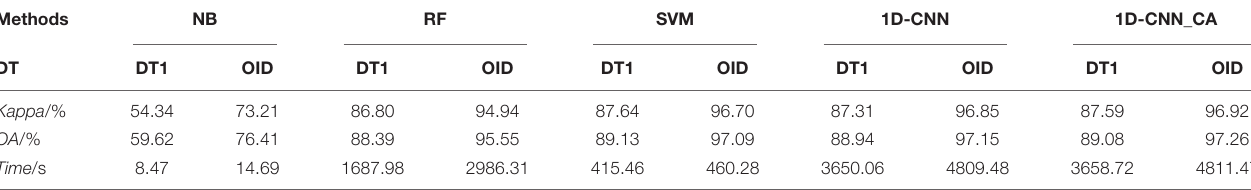
TABLE 3 | The performances of different methods based on different dataset